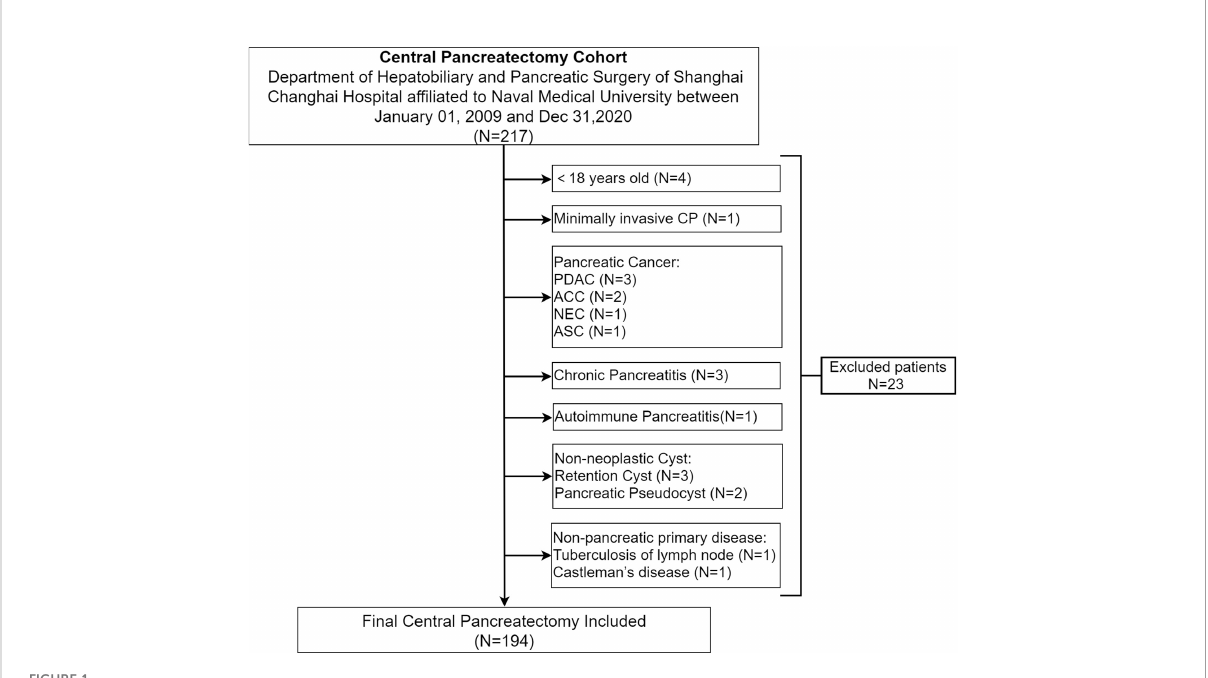
FIGURE 1 Flow chart of open central pancreatectomy